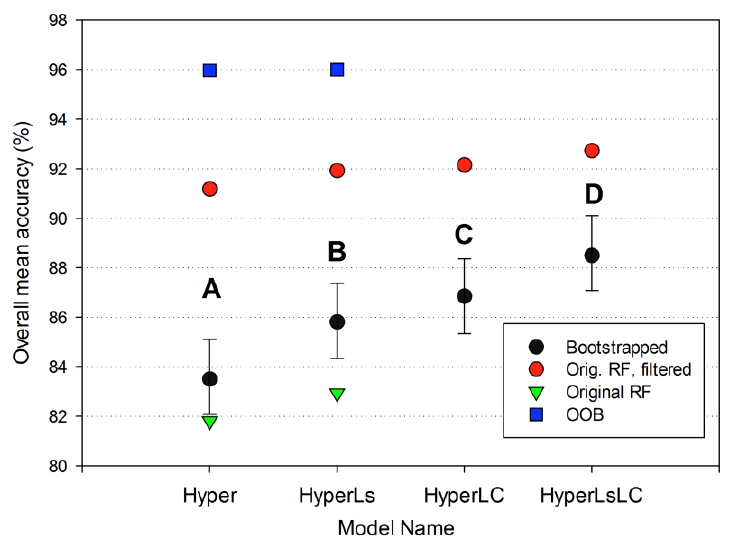
Figure 5. Overall accuracy comparison of the four Random Forest models. For each model, the bootstrapped overall accuracy for the four summary land-use classes is shown in black (mean and 95% confidence intervals), and the original unbootstrapped accuracy is shown in red. Letters denote that bootstrapped accuracy is significantly different for all of the models ( p < 0.0001). For the two models on the left with distinct RF classification models (see text), we show the overall mean accuracy of the full twenty-class RF model on the original unbootstrapped testing data and the corresponding OOB accuracy for the same twenty-class